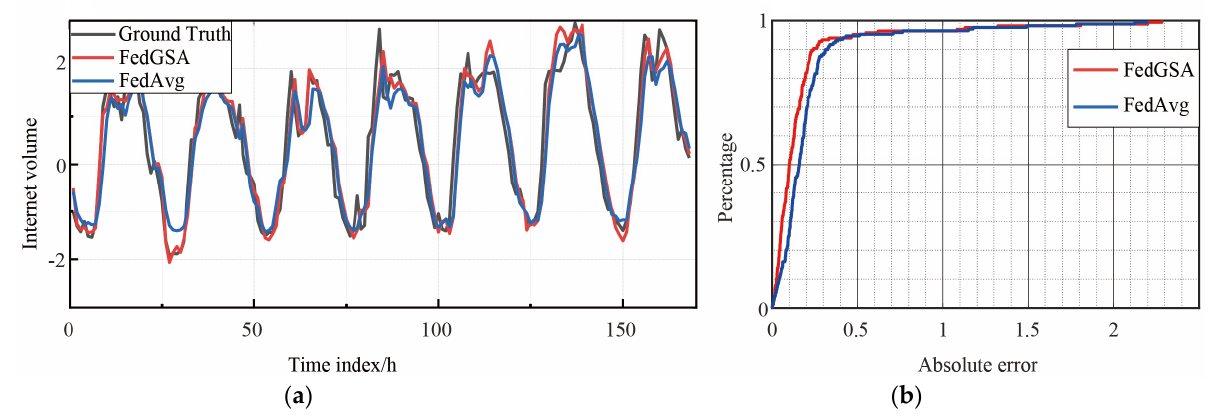
Figure 6. ( a ) describes the traffic comparison on the Trento dataset; ( b ) describes the results of the cumulative distribution function (CDF) on the Trento dataset.